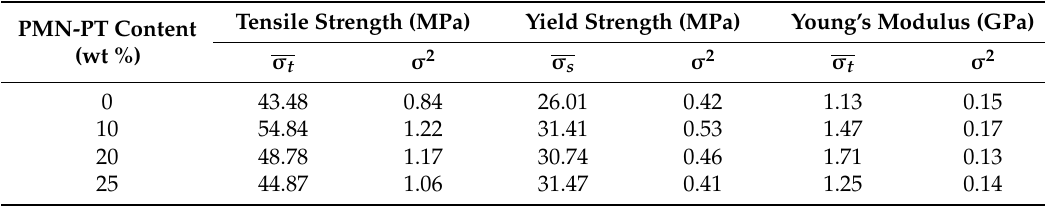
Figure 3. Stress–strain curves of nanocomposites with different PMN-PT content. Table 1. Tensile testing results of PMN-PT/poly(vinylidene fluoride) (PVDF) nanocomposites.